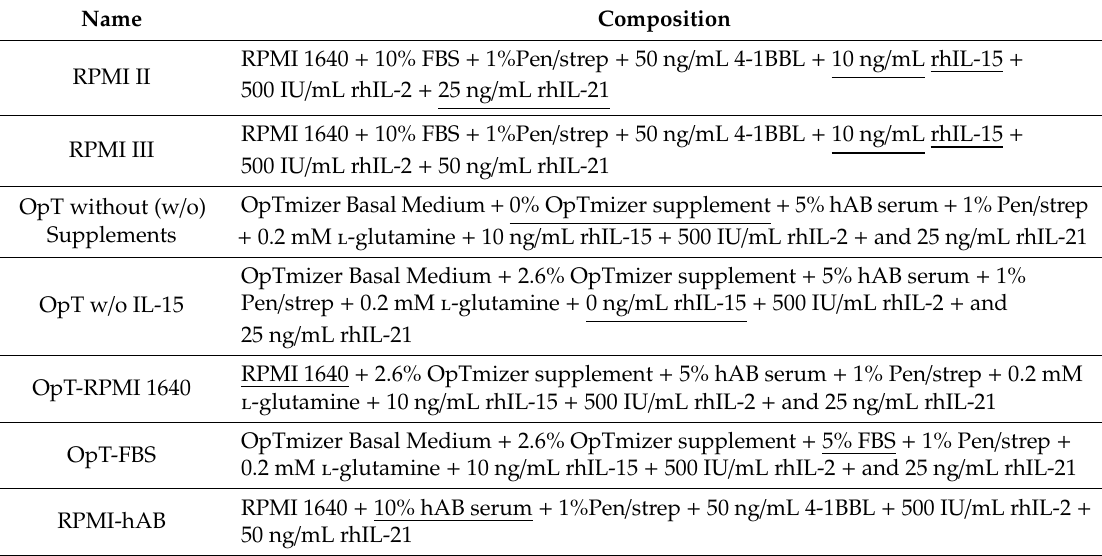
Table 1. Experimental compositions of natural killer (NK) cell culture